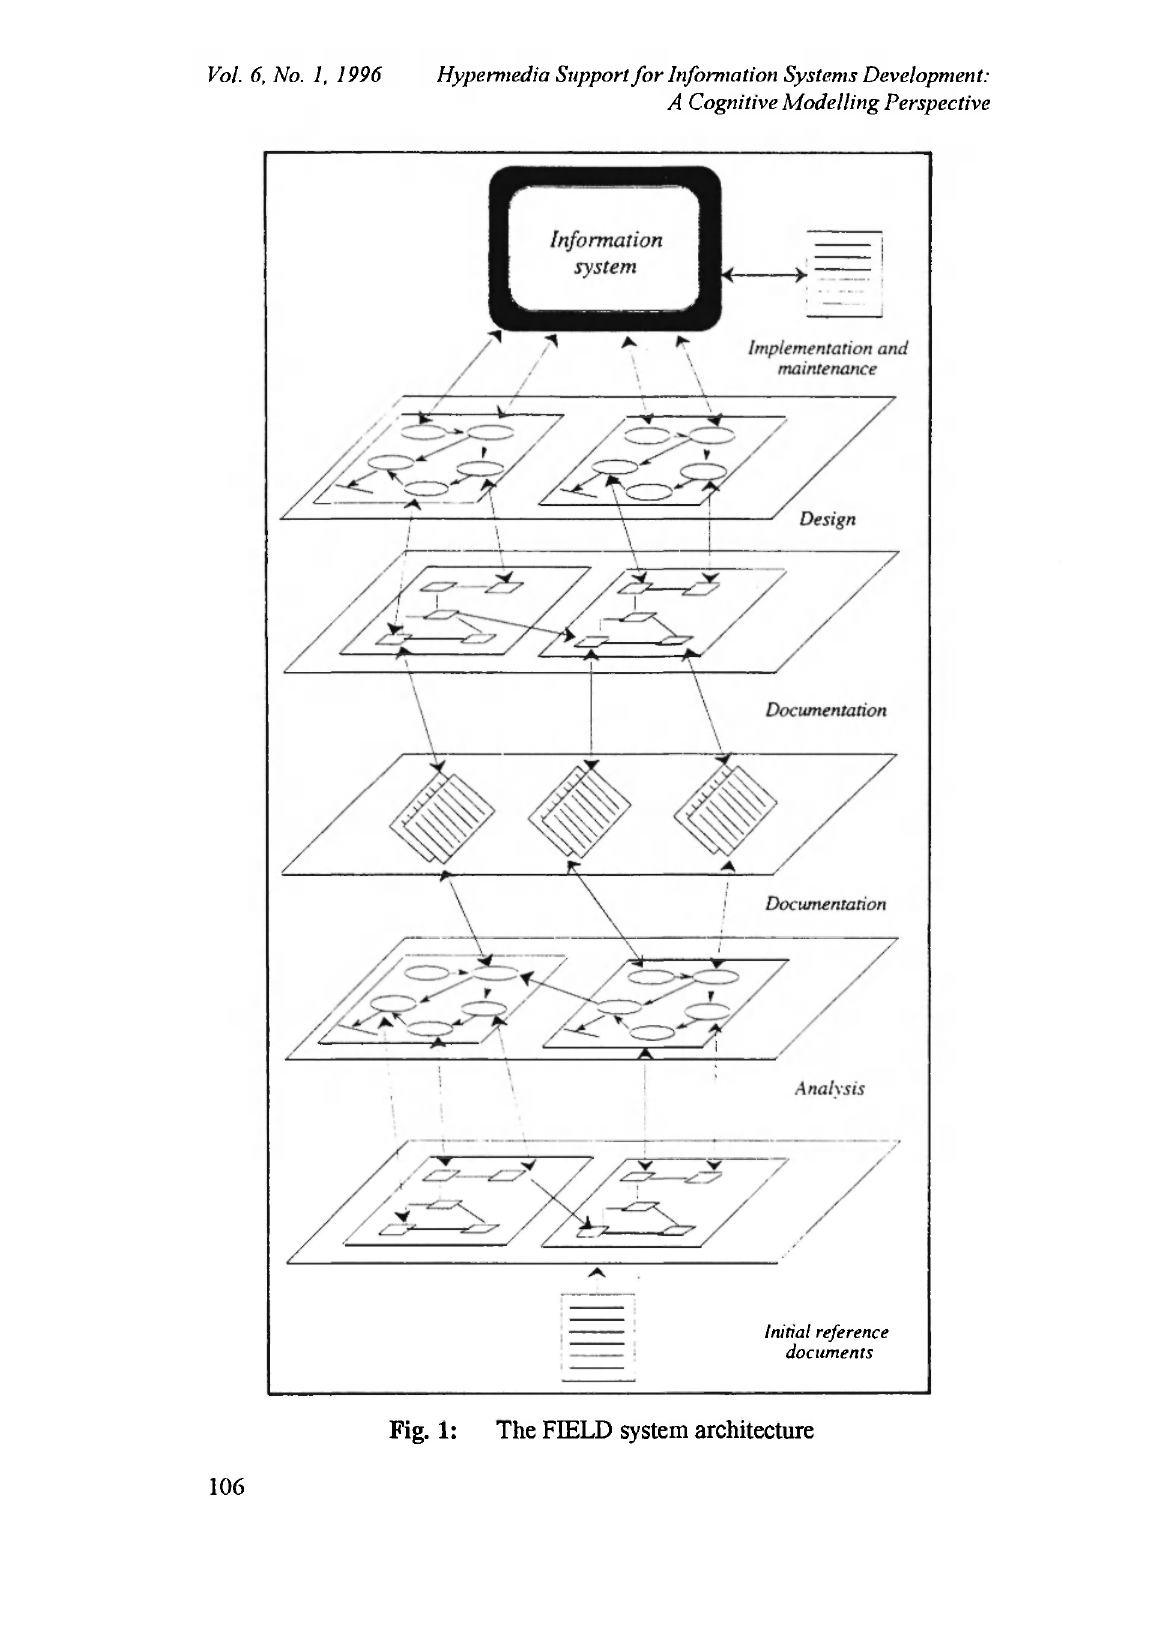
Fig. 1: The FIELD system